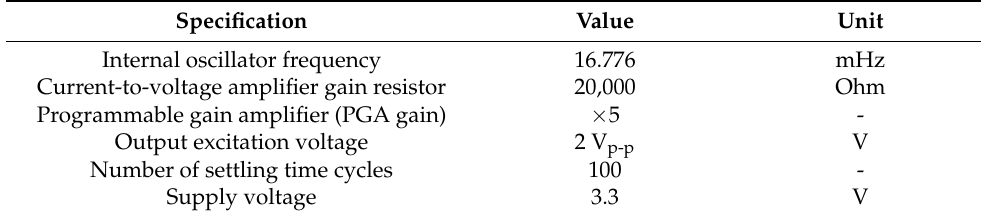
Table 3. Initial setup of impedance sensing module ‘ PmodIA ’ .